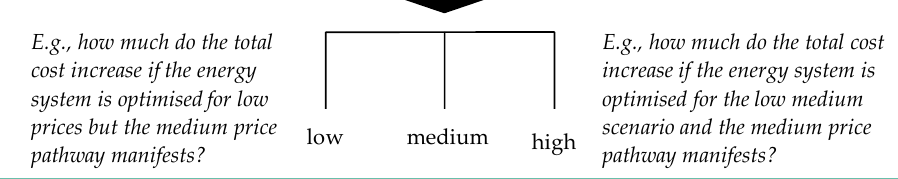
Figure 5. Process to compare the optimisation results (uncertain CO 2 prices). It should be noted that the result comparison process leads to the deterministic so- lutions not having any cost deviations for the cases where the assumed future manifests (e.g., the energy system is prepared for SOW_1 and SOW_1), as this is the optimal solution. One the other hand, the stochastic solutions have cost deviations for all scenarios, as SP does not yield an optimal solution for specific scenarios, but a robust solution across all defined